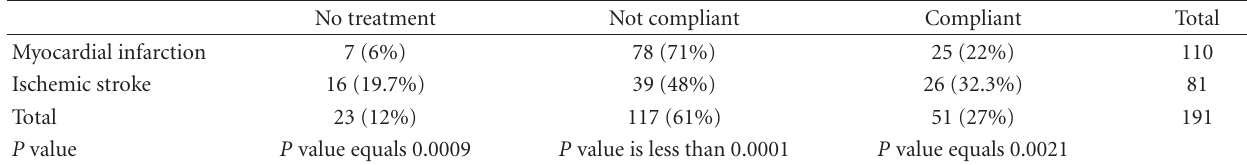
Table 3: Treatment compliance and no treatments in both groups of myocardial infarction and ischemic stroke.